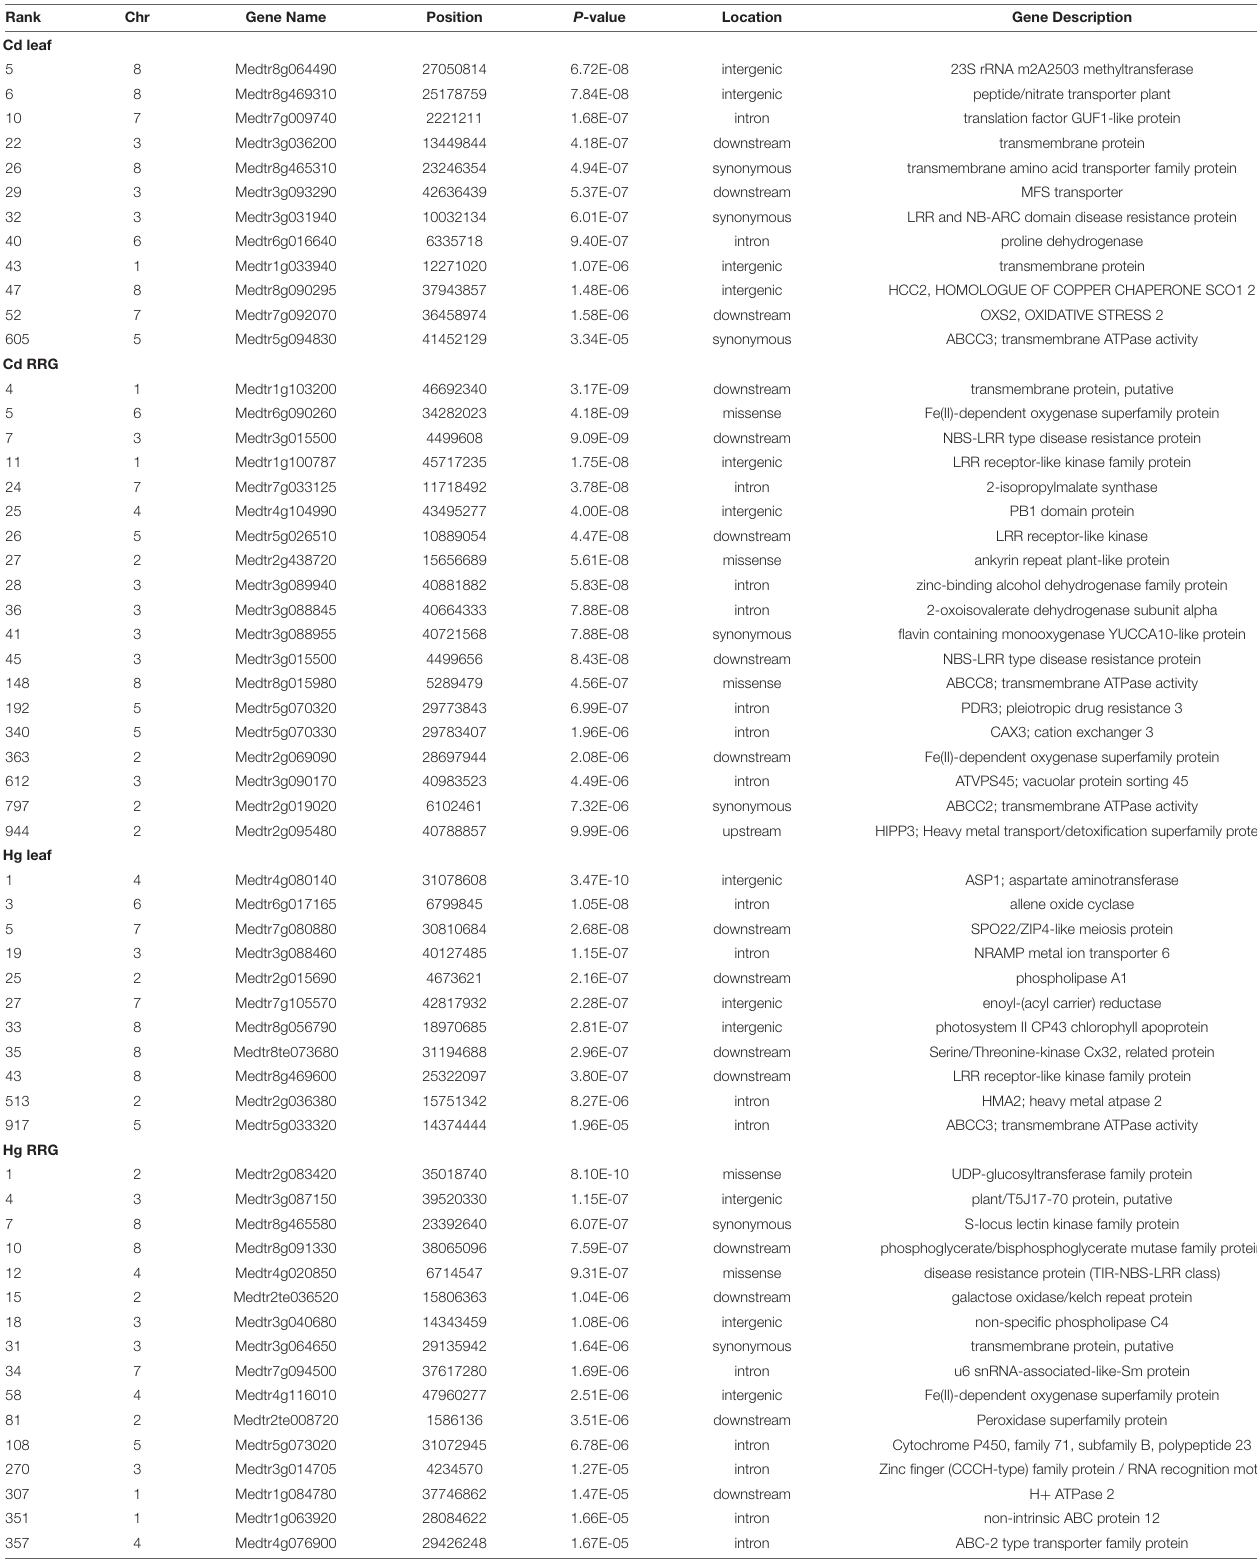
TABLE 1 | Candidate genes for each trait within 1 kb proximity to top 50 SNPs and a subset of the top 1000 SNPs identified by GWAS.